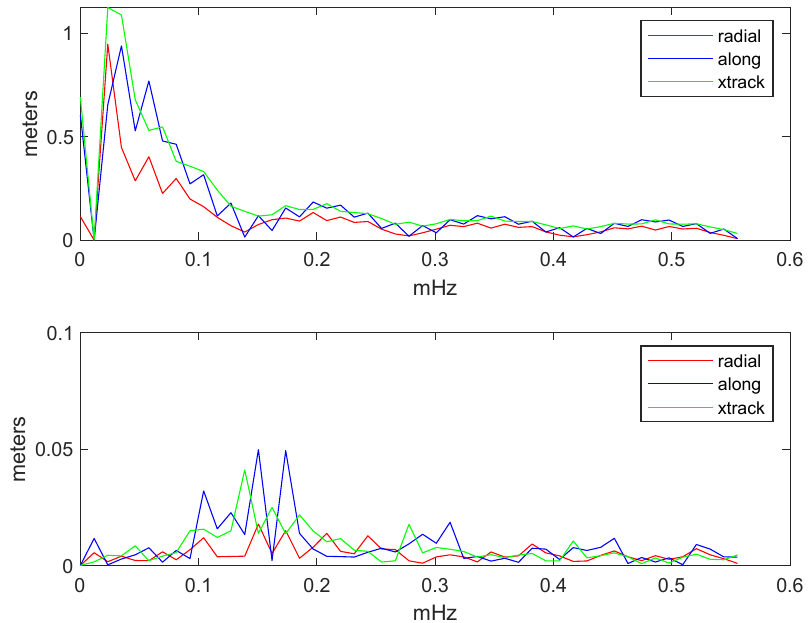
Figure 17. Spectrum of the pre-fit (top) and post-fit (bottom) residuals of the coordinates of the Galileo satellites relative to the CNES precise ephemeris, projected on the radial, tangential and across track basis. Average values for January 2020.